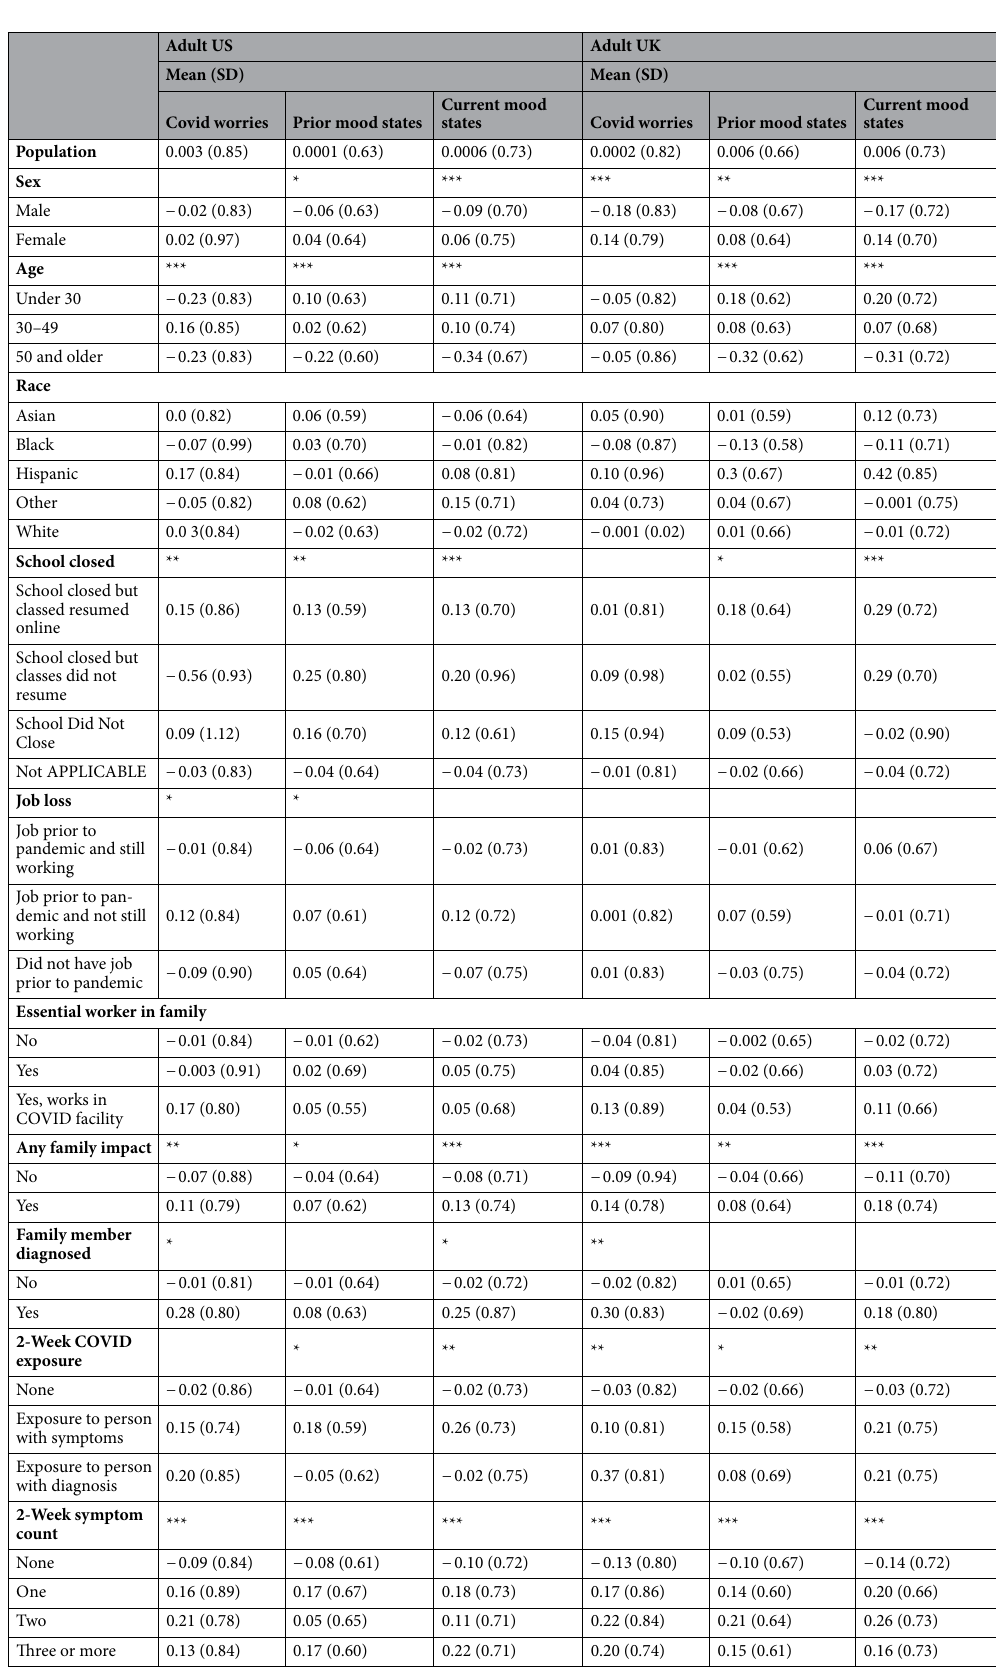
Table 3. Mean factor scores for unidimensional constructs among adults by demographic and COVID- related characteristics. Significant group differences are represented by asterisks, uncorrected for